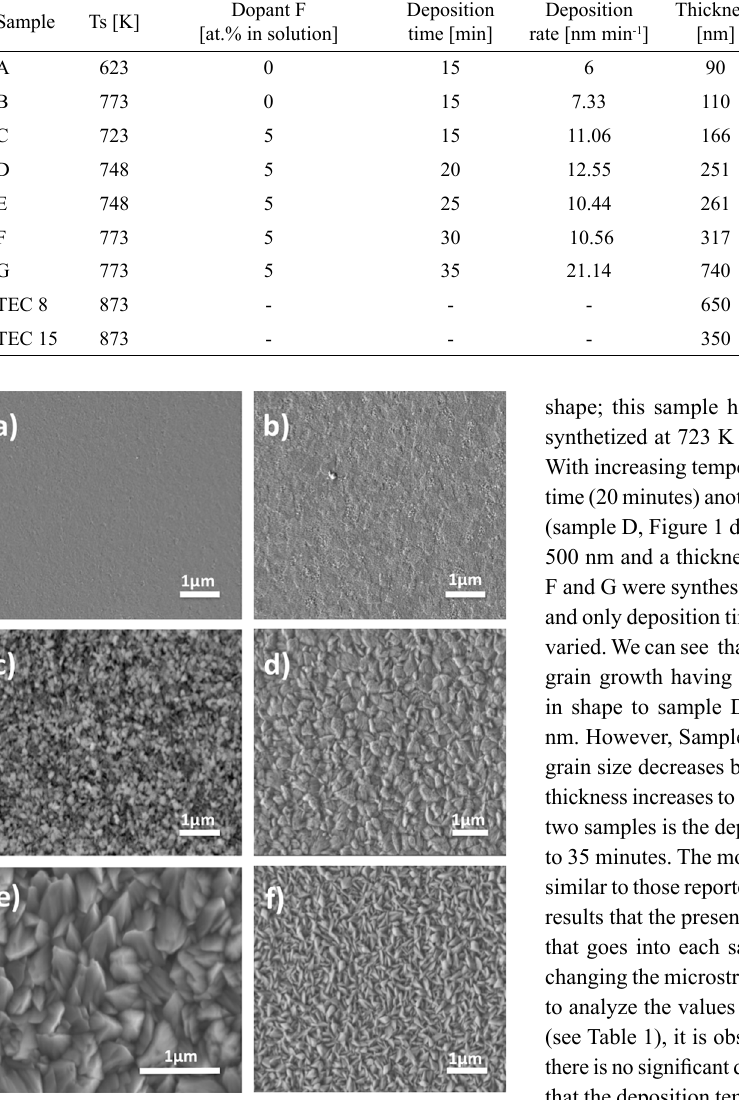
Figure 1: (a-f). SEM images of the surface morphology of the all samples. a and b) Samples A and B, c-f) Doped samples (SnO synthetized at different temperature and deposition